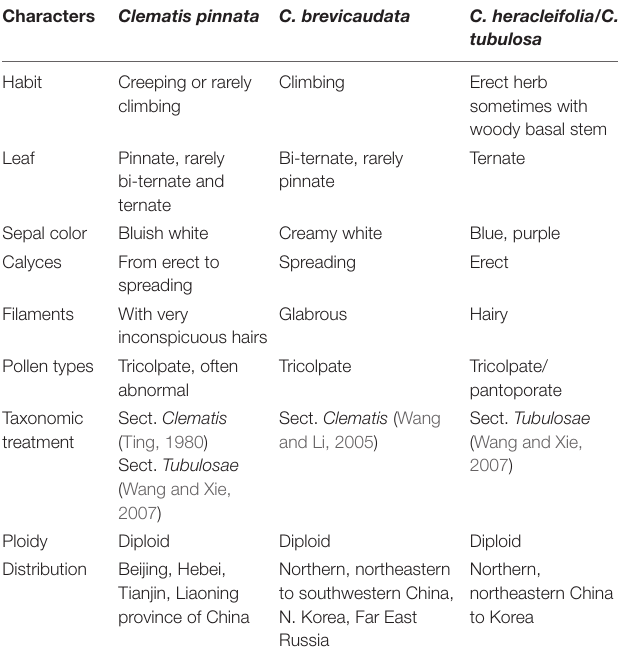
TABLE 1 | A comparison of morphological characters of Clematis pinnata and its putative progenitors. Characters Clematis pinnata C.